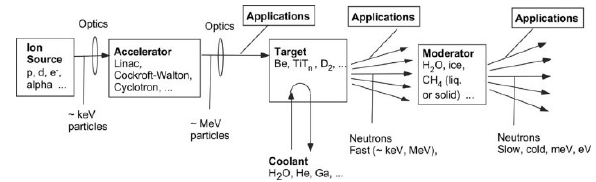
Fig. 1. Caption of the Figure 1. Below the figure